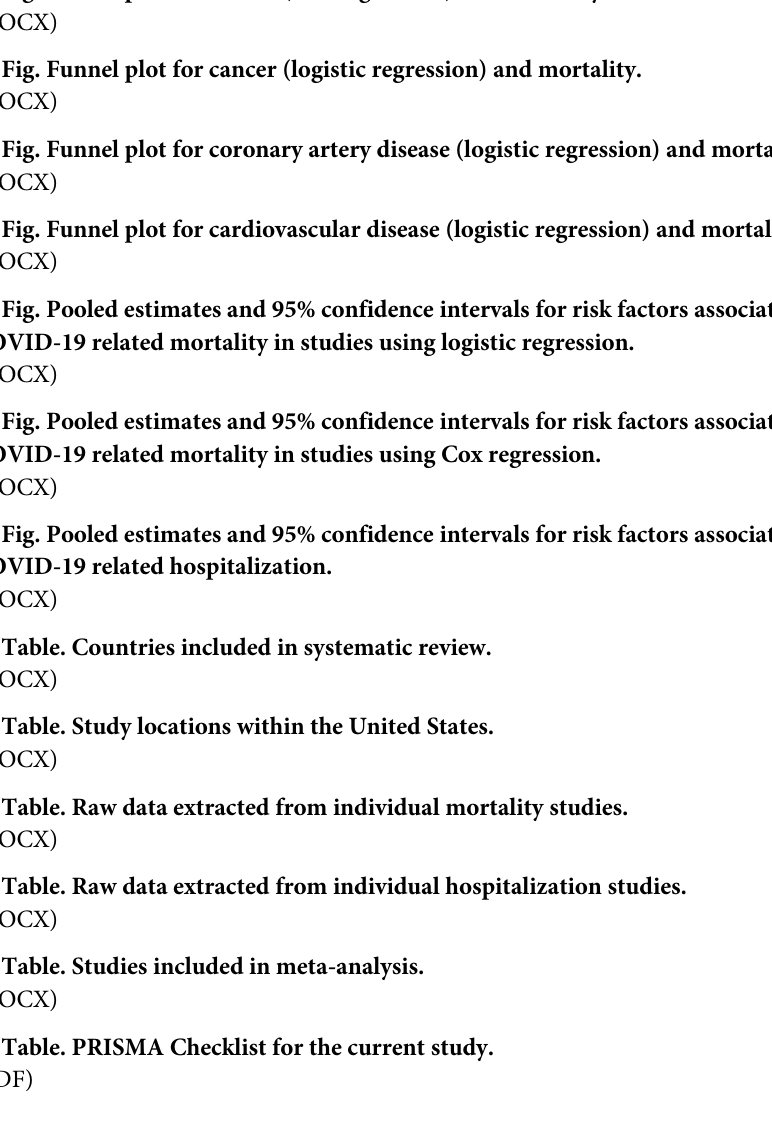
S5 Fig. Funnel plot for cardiovascular disease (logistic regression) and mortality. S6 Fig. Pooled estimates and 95% confidence intervals for risk factors associated with COVID-19 related mortality in studies using logistic regression. S7 Fig. Pooled estimates and 95% confidence intervals for risk factors associated with COVID-19 related mortality in studies using Cox regression. S8 Fig. Pooled estimates and 95% confidence intervals for risk factors associated with COVID-19 related